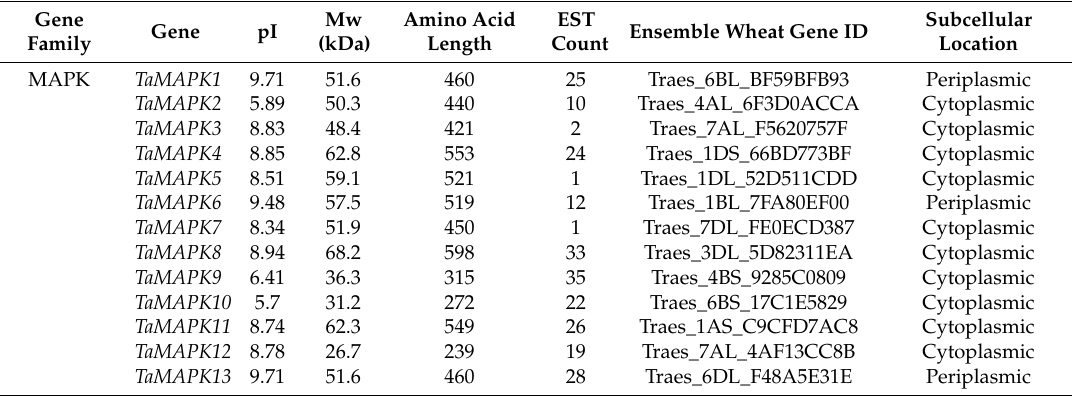
Table 1. Characteristics of putative wheat mitogen-activated protein kinase (MAPK) and MAPK kinase (MAPKK)